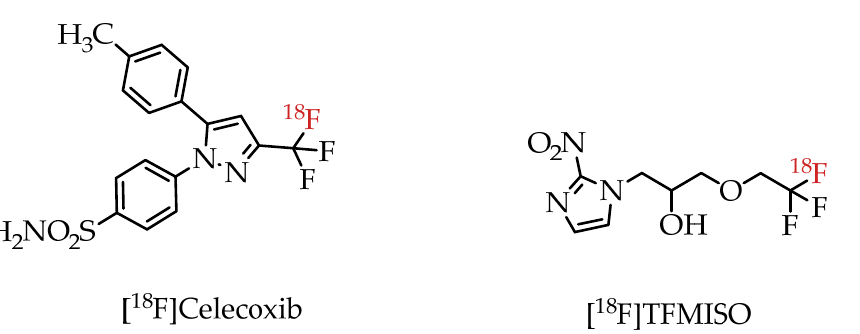
Figure 4. [ 18 F]Trifluoromethylated PET imaging agents [ 18 F]Celecoxib and [ 18 F]TFMISO.